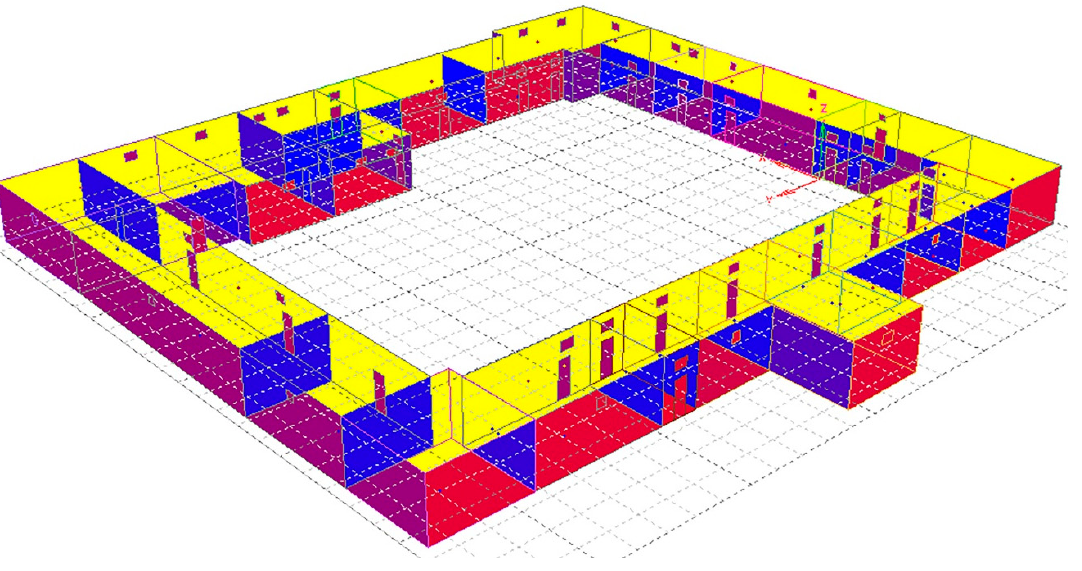
Figure 4. The compound zones.